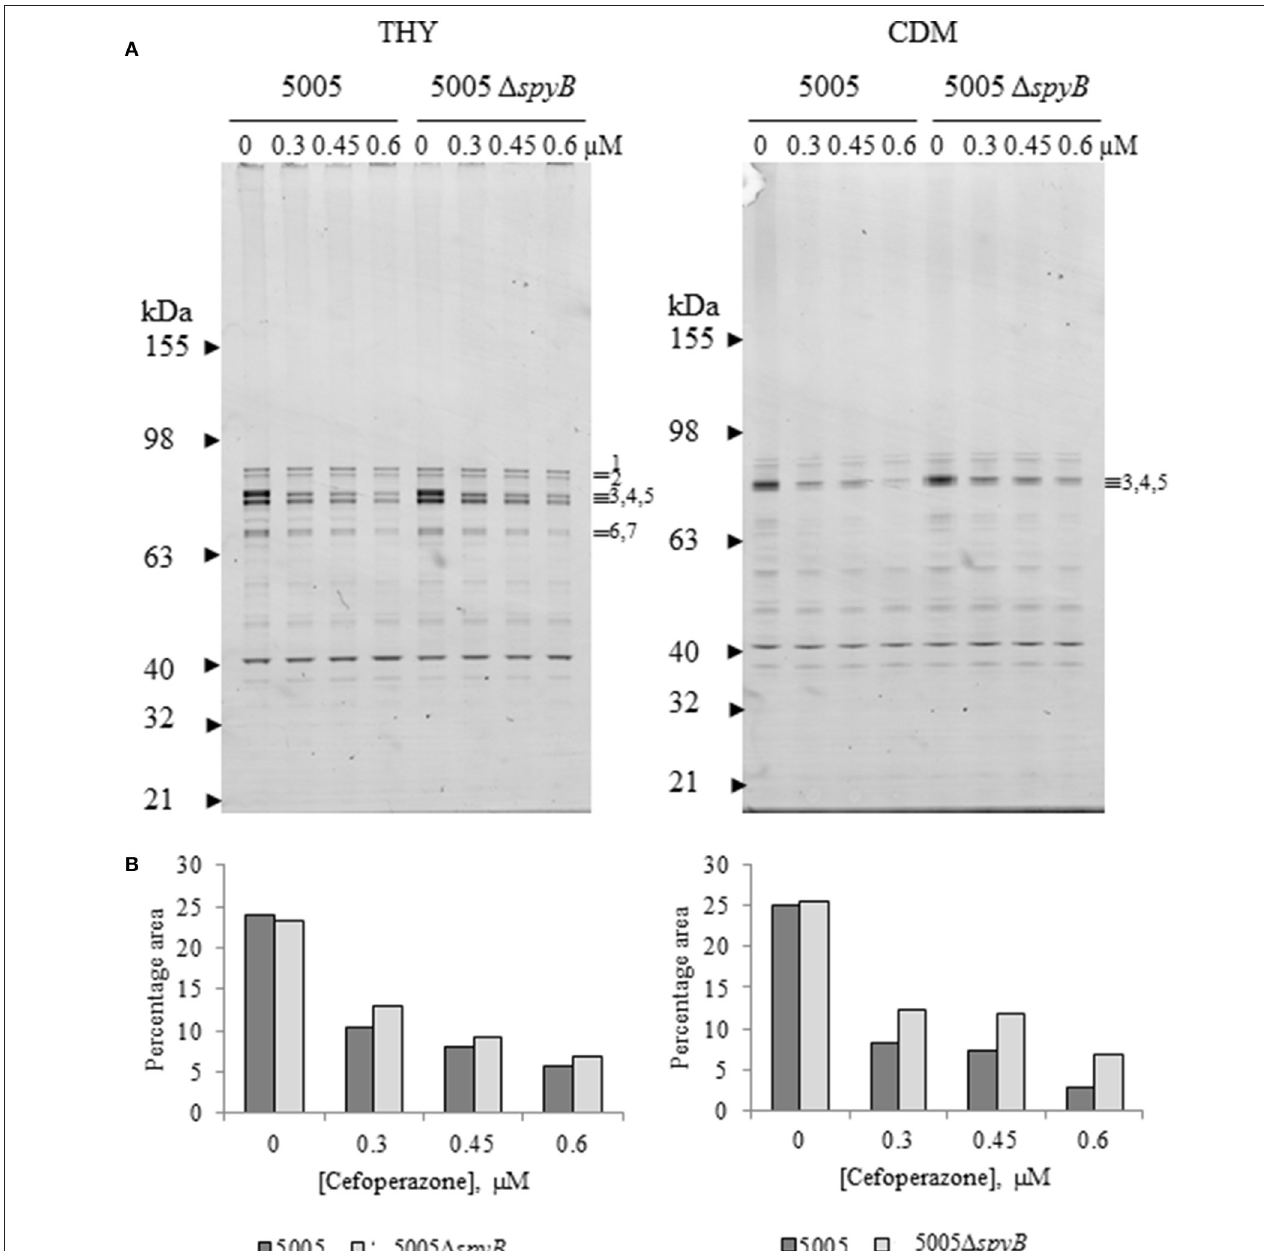
FIGURE 4 | Cefoperazone inhibition of PBPs in MGAS5005 and 5005 1 spyB . (A) Gel-based analysis of PBP expression in MGAS5005 strains grown in THY medium or CDM. Whole cells were treated with various concentrations of cefoperazone and subsequently labeled with Boc-FL. Membrane fractions were separated on 4–12% SDS-PAGE gels and visualized as described in Materials and Methods. (B) Densitometry analysis of bands 3, 4, and 5 for the gels shown in panel (A) . Data are representative of biological triplicates.